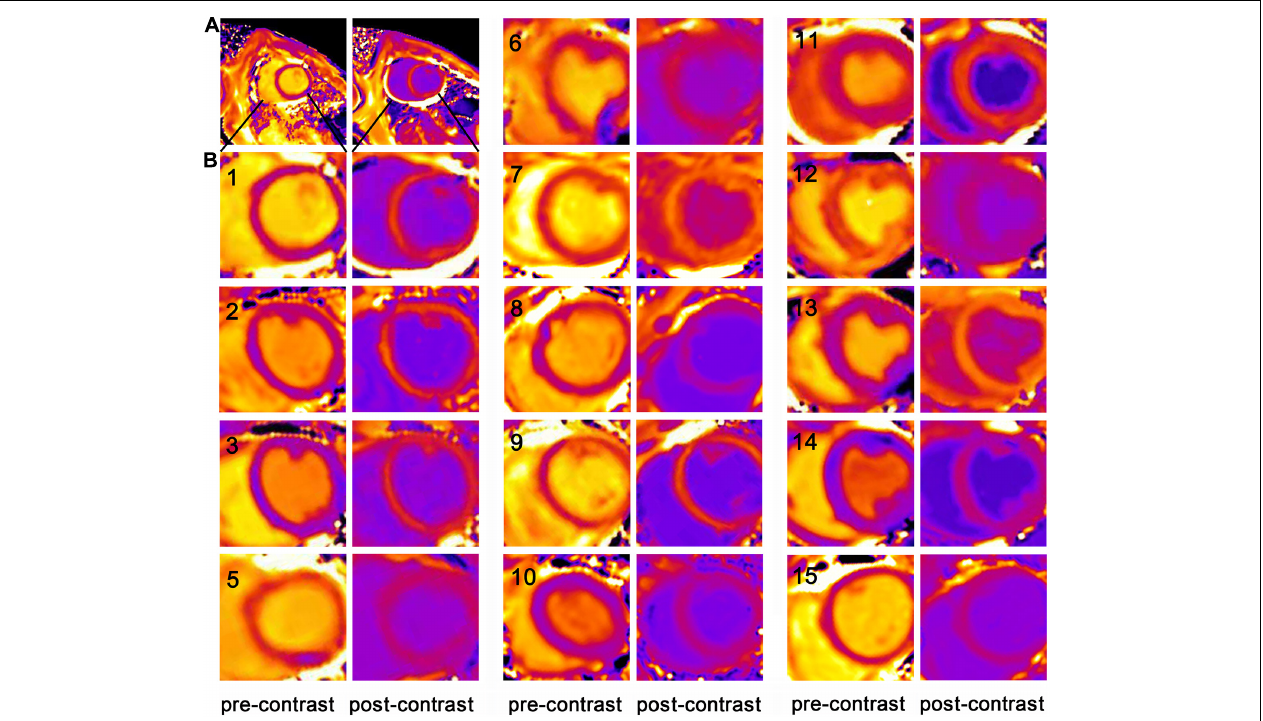
FIGURE 1 | The short-axis T1 maps of the porcine model. (A) An example of the short-axis T1 maps at the mid-papillary muscle level pre- and post-contrast in the healthy porcine model (Animal number 1). Only one representative post-contrast T1 map was chosen from multiple post-contrast time points and displayed here. (B) As artifacts occasionally appeared on the free wall of the left ventricle, but no artifact was detected in the ventricular septum, the magnified images focusing on the ventricular septum at the mid-papillary muscle level pre- and post-contrast in the 14 healthy pigs were displayed (with each animal number listed in the images of pre-contrast T1 maps). Animal number 4 died and Animal number 16 experienced enhanced scan failure. T1 values were measured from the ventricular septum and the left ventricular blood pool.